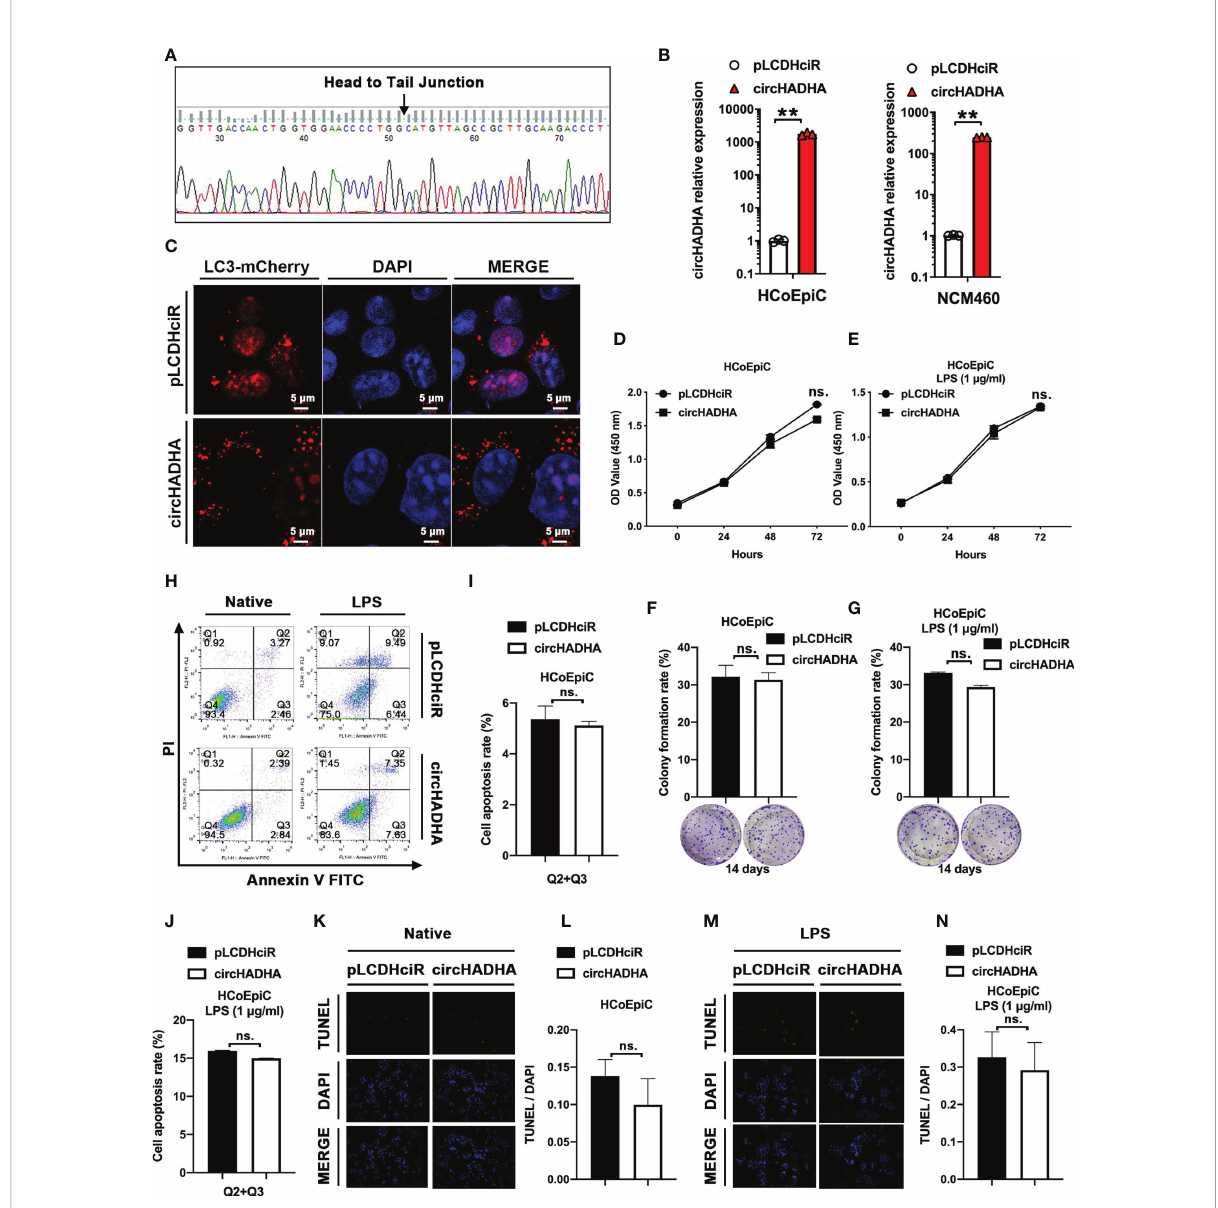
FIGURE 2 circHADHA increased autophagy in LPS-injured colon epithelial cells. (A) The sequence of head-to-tail splice junction in circHADHA. (B) The generation of circHADHA-overexpressing HCoEpiC (left panel) and NCM460 (right panel) cells. (C) The LC3B-mCherry-based autophagy assays in HCoEpiC. Overexpression of circHADHA promoted LC3B-positive autophagosomes compared with corresponding control in LPS-injured HCoEpiC. Cell autophagy was observed and imaged by the laser scanning confocal microscope. mCherry represented LC3B-positive autophagosomes. Cell nuclei were labeled with DAPI. (D, E) The performance of CCK-8 proliferation assays. Overexpression of circHADHA did not alter cell viabilities in HCoEpiC (D) and LPS-injured HCoEpiC (E) . (F, G) The performance of colony formation assays. The overexpression of circHADHA did not affect colony formation in HCoEpiC (F) and LPS-injured HCoEpiC (G) cells. (H – J) The performance of apoptosis by fl ow cytometry. Overexpression of circHADHA did not regulate apoptosis compared with corresponding control in HCoEpiC (H, I) and LPS-injured HCoEpiC (H, J) . (K – N) The performance of apoptosis by TUNEL assays. Overexpression of circHADHA did not change apoptosis compared with corresponding control in HCoEpiC (K, L) and LPS-injured HCoEpiC (M, N) . Three independent experiments were performed. ** P < 0.01; ns, no signi fi cant